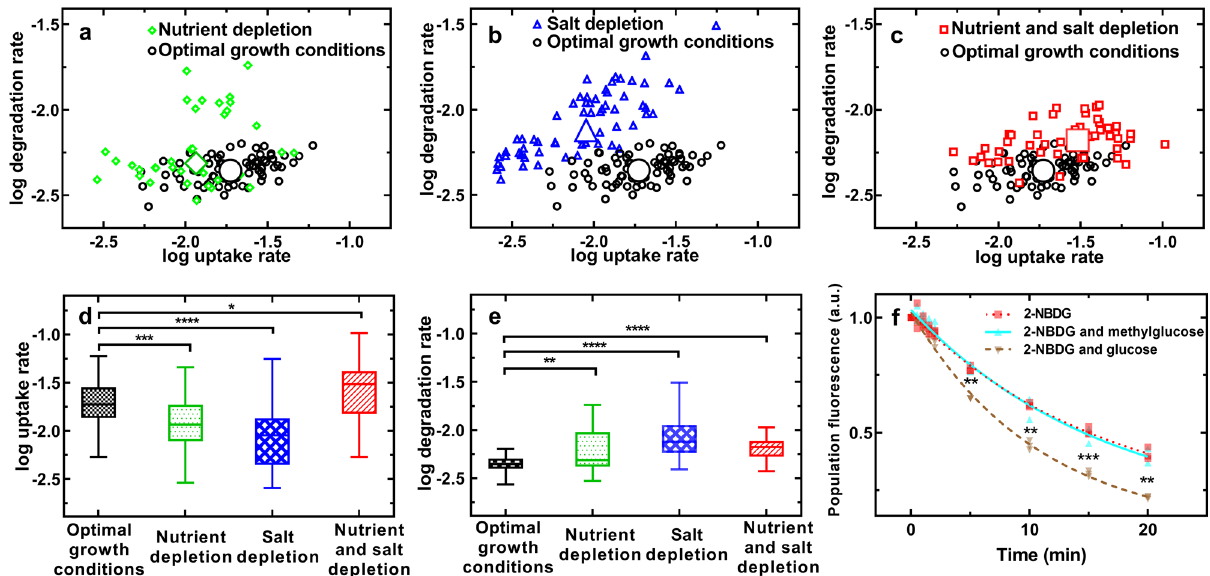
Fig. 4 Combined nutritional and salinity depletion boosts both glucose uptake and degradation. a – c Single-cell correlation between the natural logarithm of 2-NBDG uptake rate and the natural logarithm of 2-NBDG degradation rate as predicted by Equation 1 for optimal growth conditions (circles), nutrient depletion (diamonds), salt depletion (triangles) or combined nutrient and salt depletion (squares), with Pearson correlation coef fi cients of 0.42 (***), 0.27 (ns), 0.80 (****) and 0.36 (*), respectively. N > 30 for each experimental condition collated from biological triplicates, the large symbols are the medians of each set of single-cell values. Coef fi cient of variations of these single-cell values and statistical tests of quantitative comparisons of values between different environments are reported in Supplementary Tables 5 and 6, respectively. Corresponding distributions of ( d ) natural logarithm of 2-NBDG uptake rate values and ( e ) natural logarithm of 2-NBDG degradation rate values. The bottom and top of the box are the fi rst and third quartiles, the band inside the box is the median, the bottom and top whiskers represent the 10th and 90th percentiles, respectively. f Temporal dependence of the fl uorescence of 2-NBDG when E. coli populations were incubated in 30 µ M 2-NBDG alone (red squares), in the presence of 30 mM 3-O-methylglucose (cyan upward triangles), or in the presence of 30 mM glucose (brown downward triangles). N = 3 biological replicates for each condition. The lines are one phase exponential decay fi ttings to the data yielding time constant Tau of (16.3 ± 1.1) min, (16.3 ± 1.2) min and (10.9 ± 0.5) min, respectively. * p value <